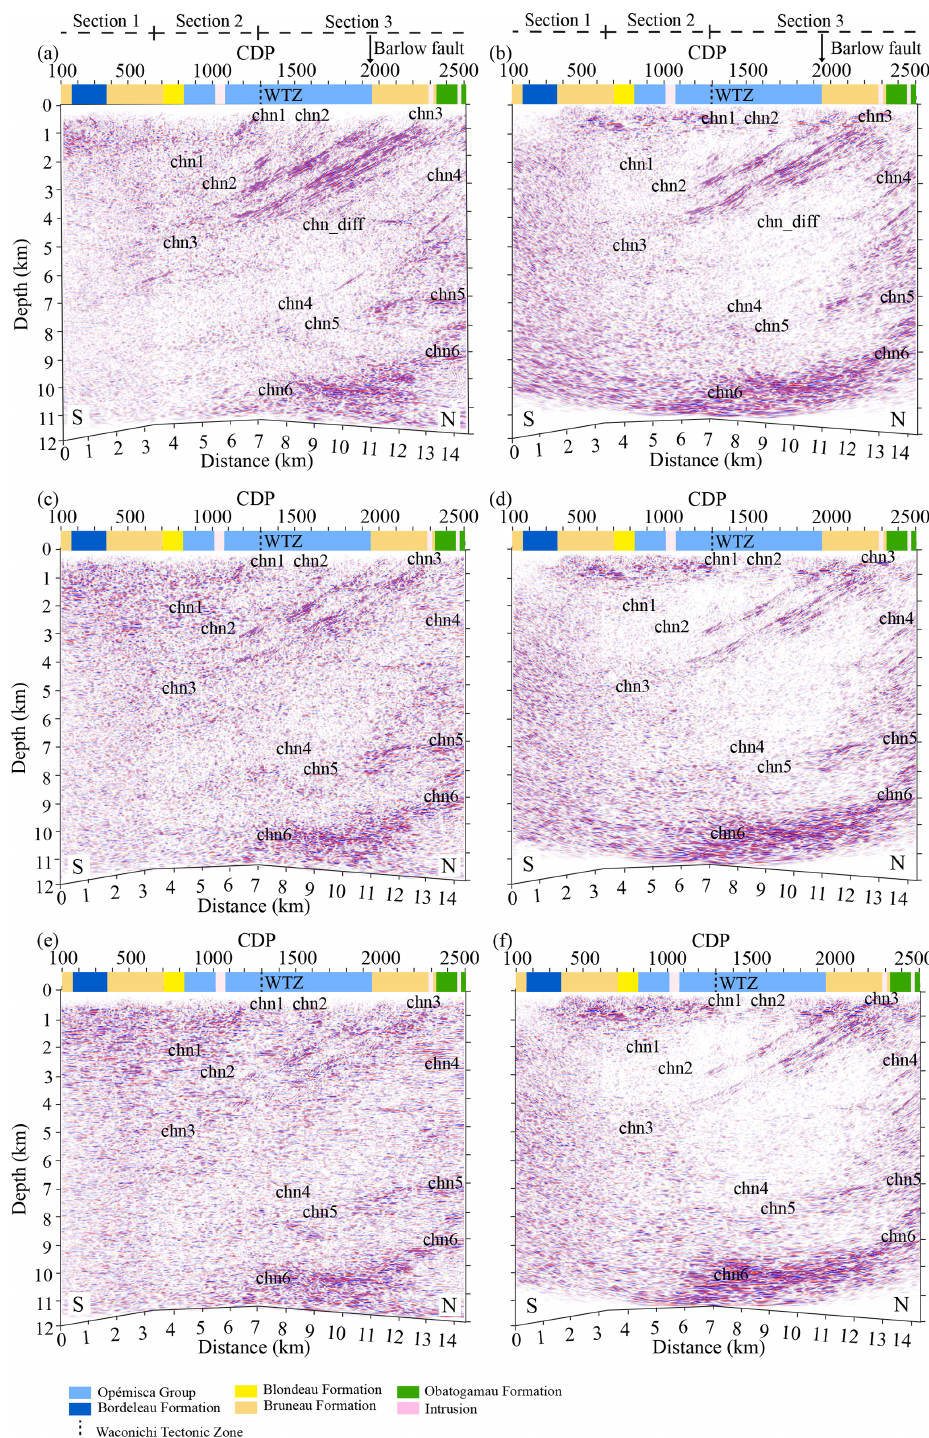
Figure 5. Migrated sections from the north survey considering an offset plane at a range of 0–9km. DMO-corrected migrated section and PSTM section shown in (a) and (b) , respectively, for an offset plane of 0–3km, in (c) , (d) , respectively, for an offset plane of 0–6km, and in (e) and (f) , respectively, for an offset plane of 0–9km. Prominent reflections are imaged in shallow and deep zones of the sections. For the interpretation of chn1, chn2, chn3, chn4, chn5, chn6, and chn_diff, see text. The survey includes three sections which are projected at the top of the image. The rock units along the survey path are projected at the top of each section with no dip in the contacts implied. The surface location of the Barlow fault is marked at the top of the